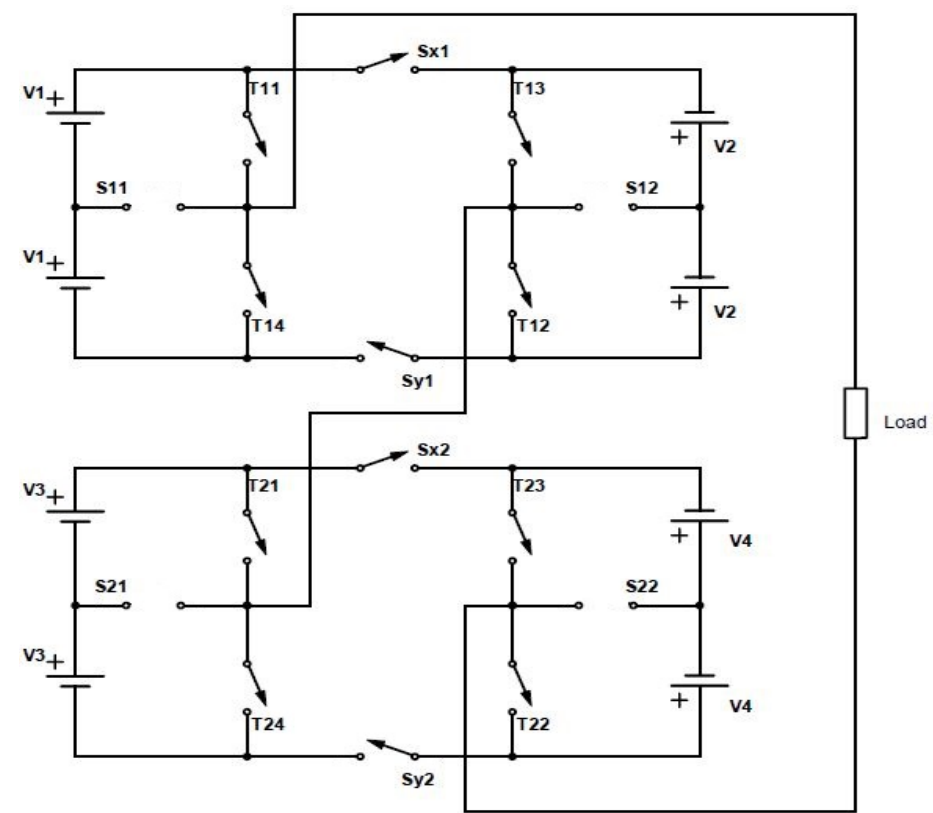
Figure 2. Cascaded two stages of SLMLI. Table 4. Switching sequence for the Proposed